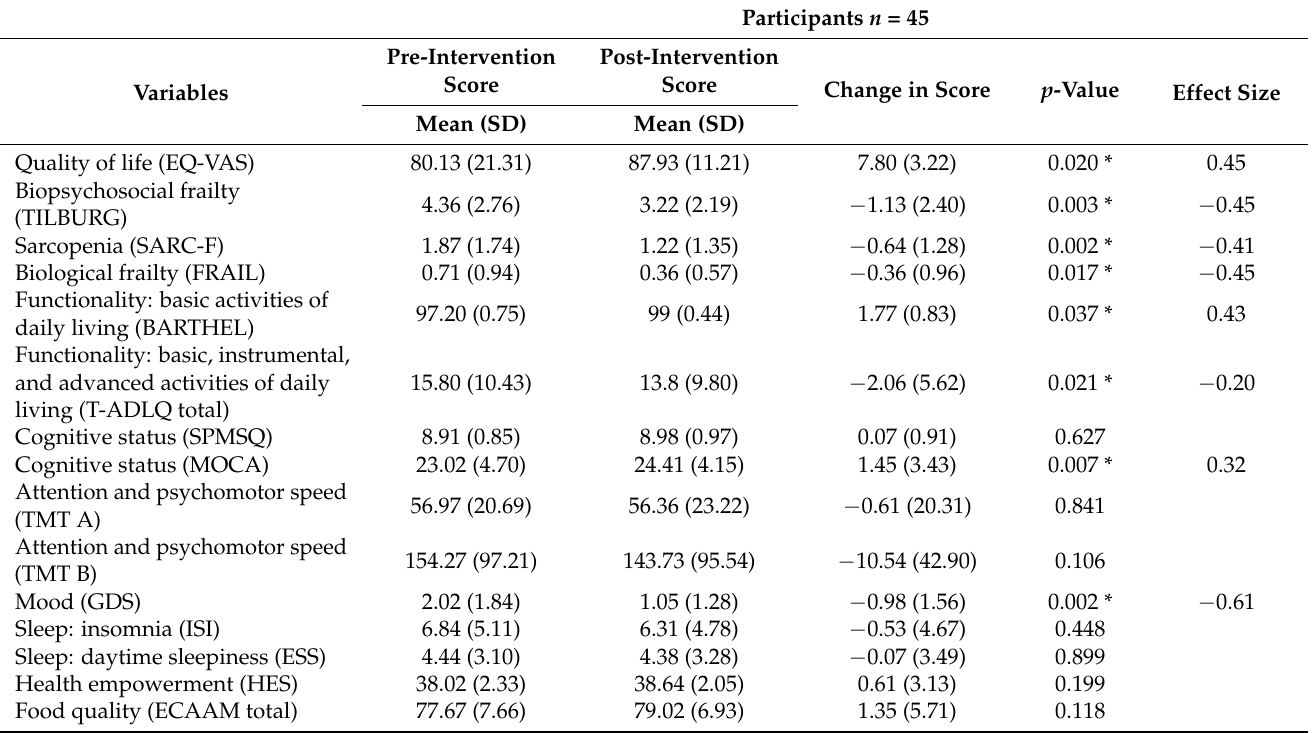
Table 2. Pre–post intervention comparison of quality of life and biopsychosocial variables among participants of a structured multicomponent physical exercise intervention.